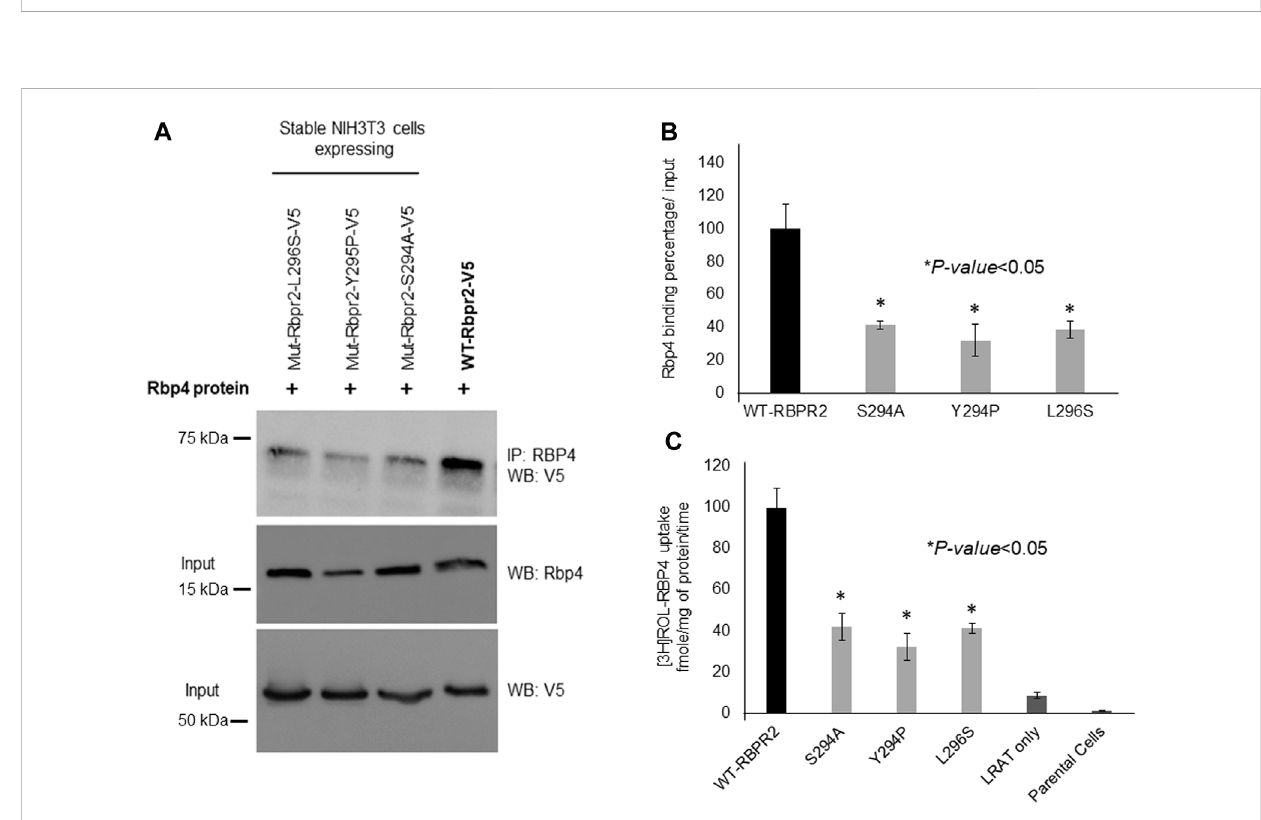
Extracellular RBP4 binding capabilities of RBPR2 and Vitamin A uptake assays. (A,B) Co-IP experiments showed a strong interaction between wild type (WT) RBPR2 and exogenous applied human RBP4 protein. Conversely, mutants targeting the proposed RBP4 binding sites on RBPR2, showed weaker interaction with RBP4 (62% – 73% decreased binding capability compared to WT-RBPR2; p < 0.05). (C) Compared to NIH3T3/LRAT/WT- RBPR2 expressing cells, all NIH3T3/LRAT/RBPR2-mutant expressing cells showed decreased ability ( < 81% of WT-RBPR2 activity; * p < 0.05) to uptake extracellular applied [ 3 H]ROL bound